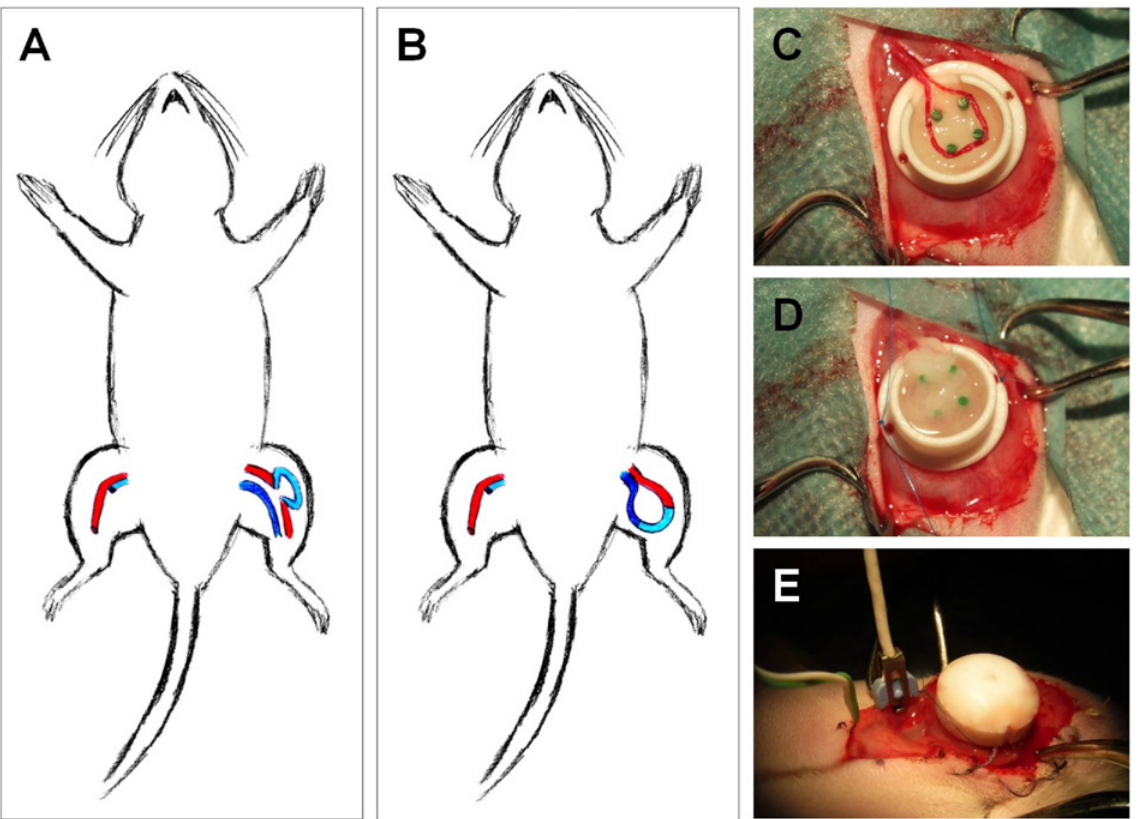
Fig 1. Experimental procedure and chamber containing the venous graft. The femoral vein was obtained from the right leg and was interpositioned as a graft in the left leg in the arterial flow pathway (arterioarterial [AA] loop, A) or the graft was used to create an arteriovenous shunt (AV loop, B) between femoral artery and vein. In both settings, the grafted vein loop was placed in an isolating teflon chamber (C) that was filled with a fibrin clot and stitched to the fascia of the underlying muscle (D). An ultrasonic transit-time flow probe was placed around the vessel entering the chamber for measurements of blood flow